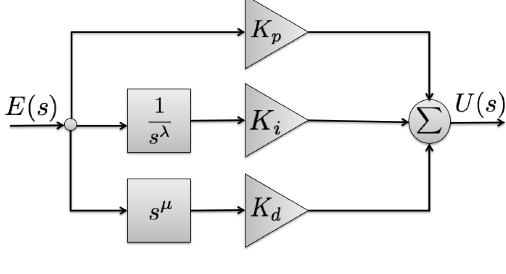
Figure 4. FOPID block